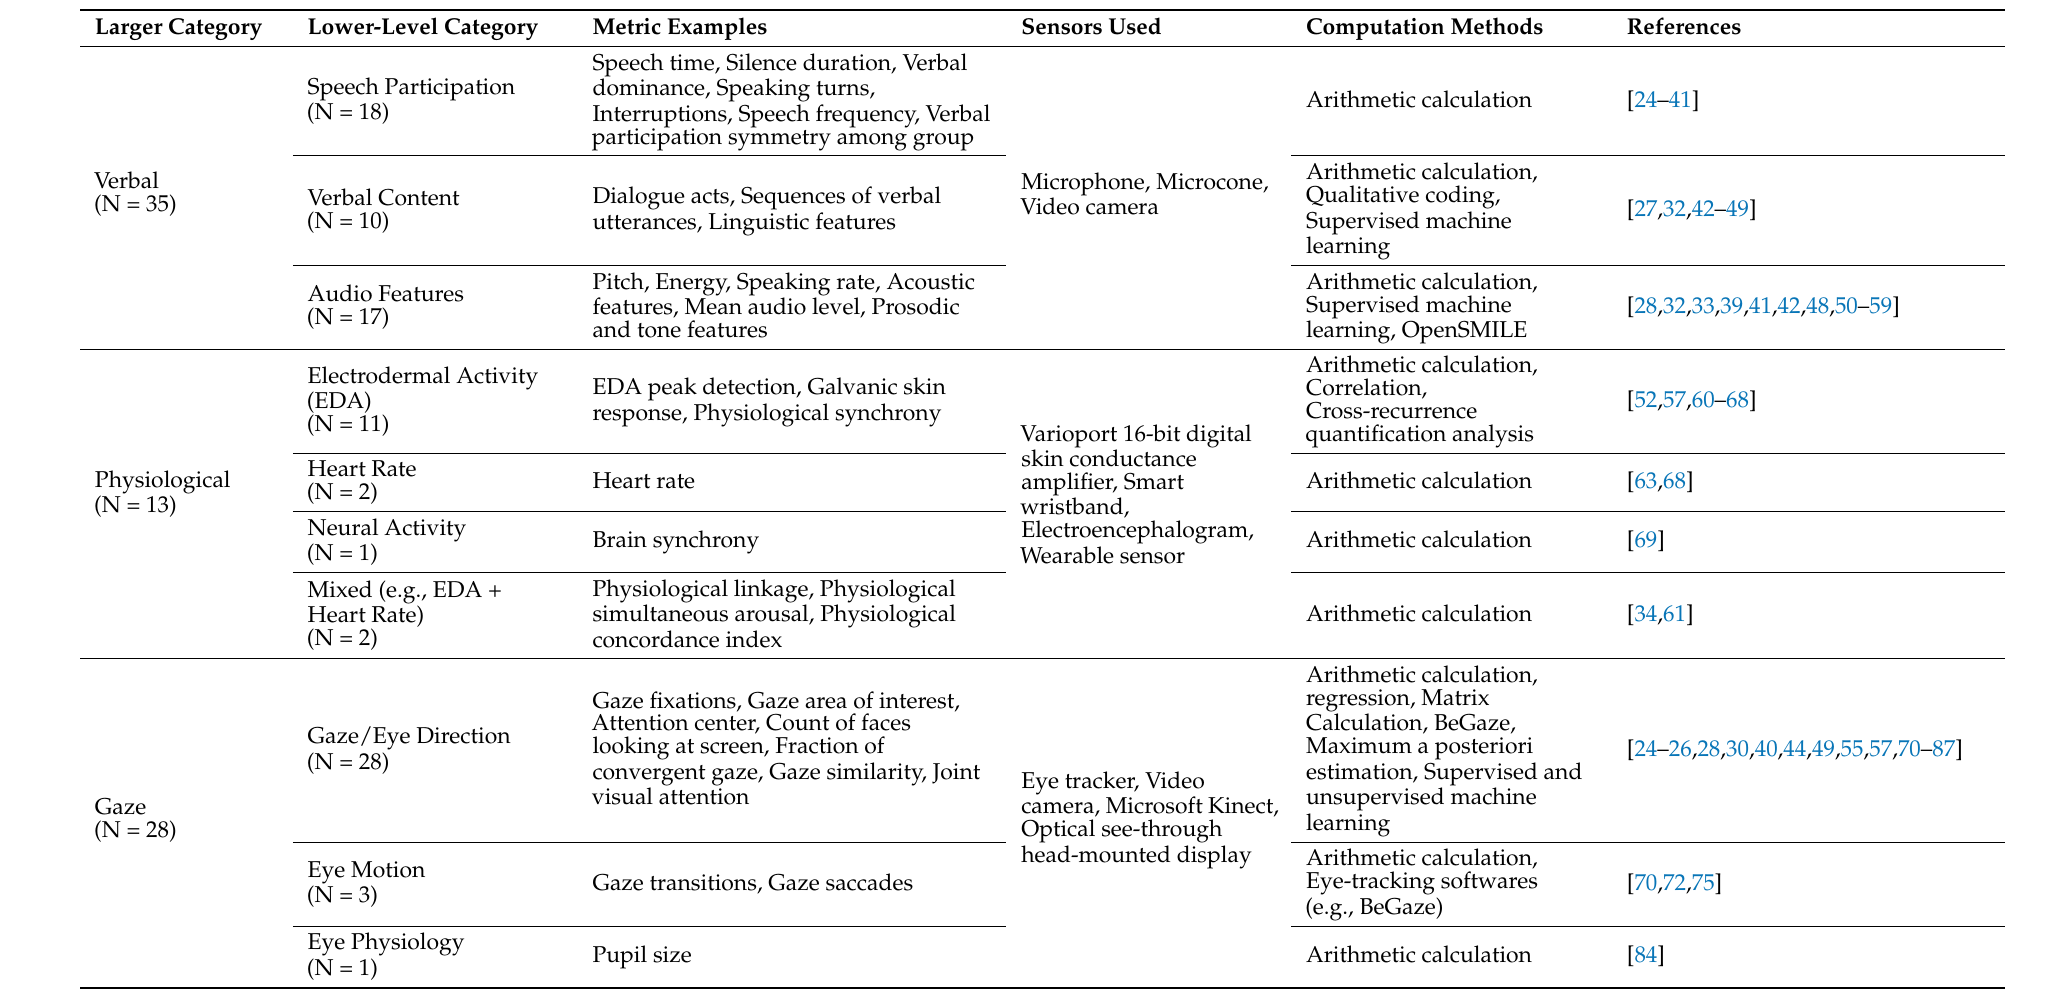
Table 1. Taxonomy of